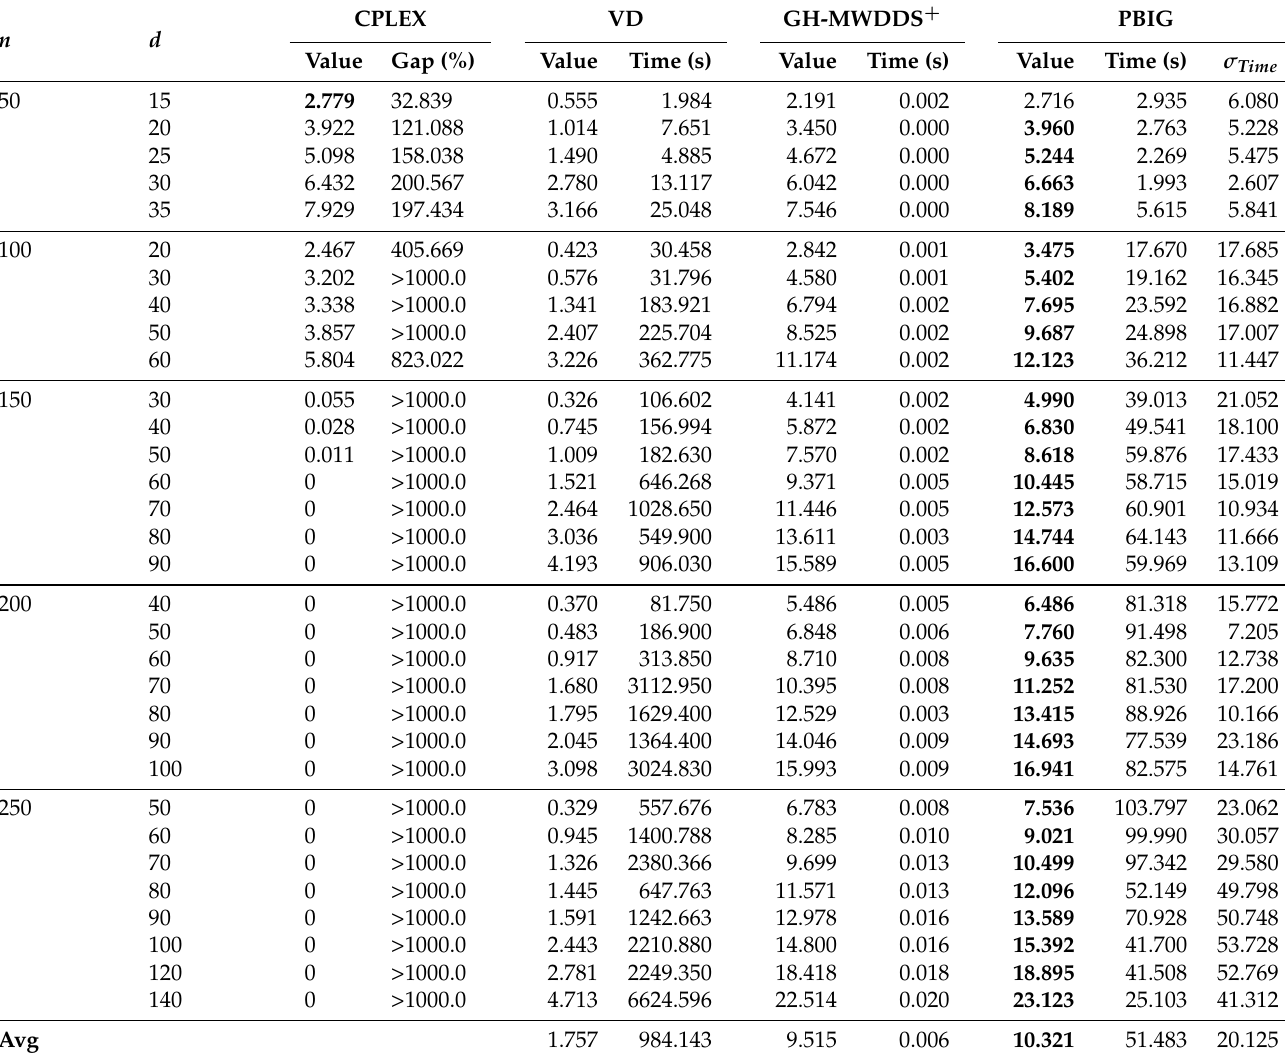
Table 2. Numerical results for the instances of S ET 1 (random